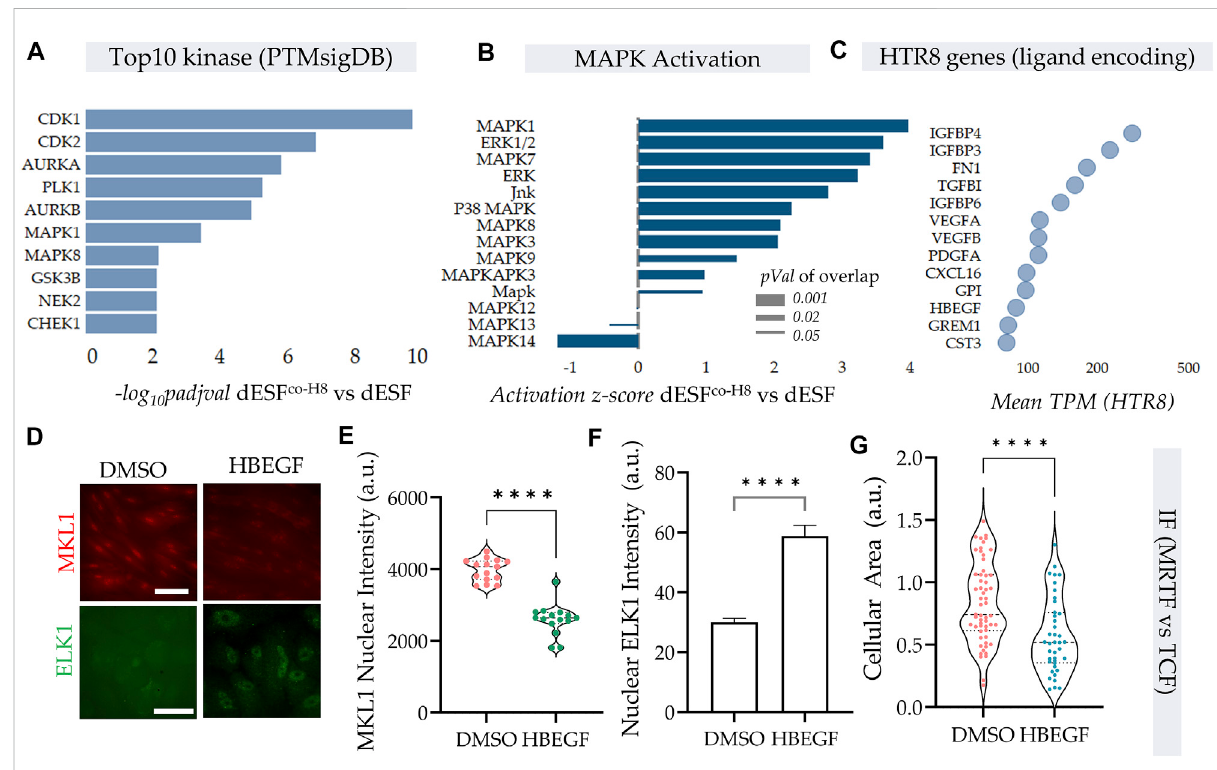
FIGURE 5 HB-EGF secreted from EVTs shift SRF-MRTF to SRF-TCF transcription. (A – C) HTR8 secreted HB-EGF activate MAPK signaling in dESF. (A) Top 10 kinases that are activated with HTR8 co-culture (dESF co − H8 vs. dESF) based on differential genes that are downstream of the predicted kinases, evaluatedusingPTMsignaturesdatabase;DatapresentedwithFDRcorrectionofpVal. (B) IPApredictedactivation scoreofMAPKspeciesindESFco- H8 vs. dESFs. (C) Bubble plot showing TPM values of genes encoding ligands expressed in HTR8. (D) Immuno fl uorescence images